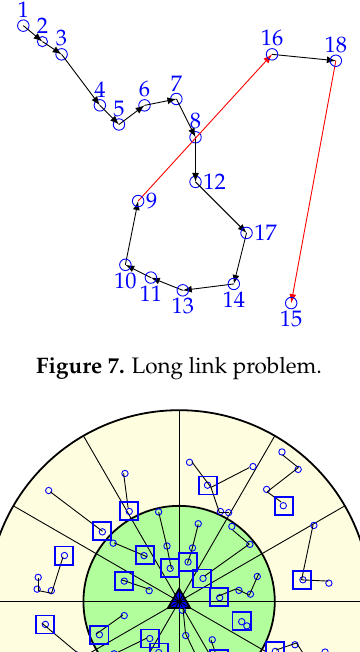
Algorithm 2: Chain construction procedure for each sector